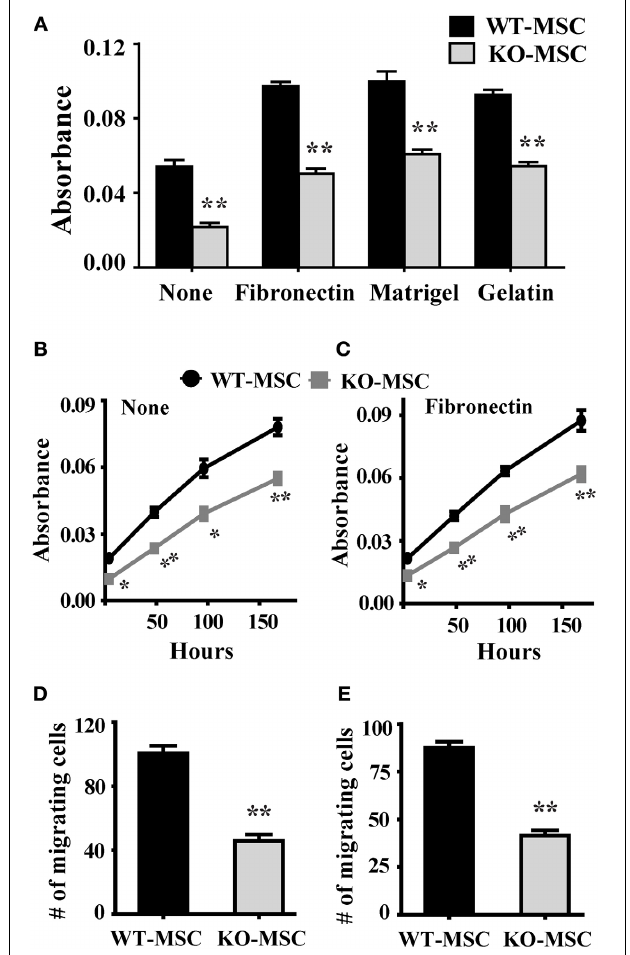
FIGURE 2 | Lack of CD13 impairs MSC adhesion, proliferation, migration, and invasion. (A) Adhesion assay: Cells (1 × 10 4 ) were seeded in 96 well plates coated separately with fibronectin, Matrigel, or gelatin and allowed to adhere for 1h at 37 ◦ C. After PBS wash, adherent cells were detected by MTT assay. n = 6, ∗∗ P < 0 . 01. (B,C) Proliferation assay: Cells (0 . 5 × 10 4 ) were seeded in 96 well plate and cell proliferation detected by MTT assay at the indicated time points. n = 6, ∗ P < 0 . 05, ∗∗ P < 0 . 01. (D) Migration assay: 1 × 10 4 cells were seeded in FluoroBlok chambers. After 4h. incubation the cells were stained with DAPI and counted. n = 4, ∗∗ P < 0 . 01. (E) Invasion assay: 1 × 10 5 cells were seeded on Matrigel (1:5 dilution) coated FluoroBlok chambers. After 6h. incubation the cells were counted. n = 4, ∗∗ P < 0 .